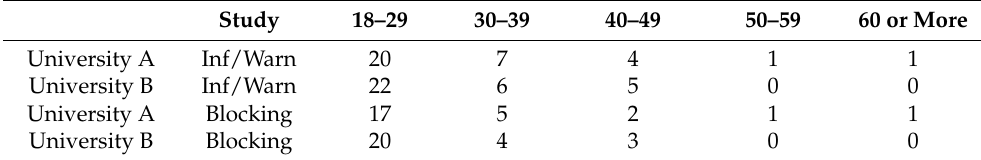
Table 26. Age ranges of participants in information/warning and blocking surveys.